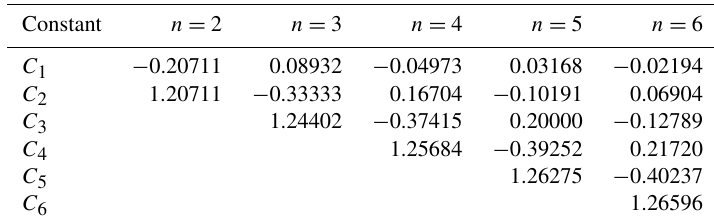
Figure 5. Recession curves at different numbers of reservoirs in SC2 model ( k SC2 = 1). Table 2. Numerical values of constants of integration to recession curves in the SC2 model ( k = 1, Q 0 =